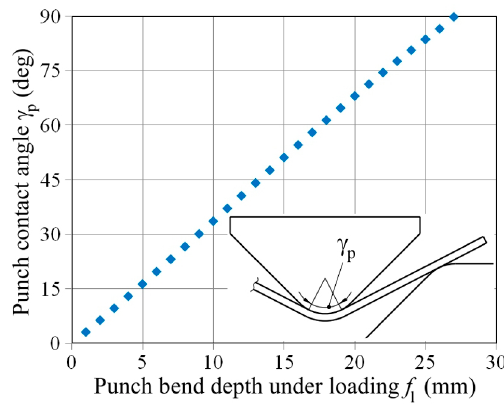
Figure 13. Effect of the bend depth under loading f l on the punch contact angle γ p .